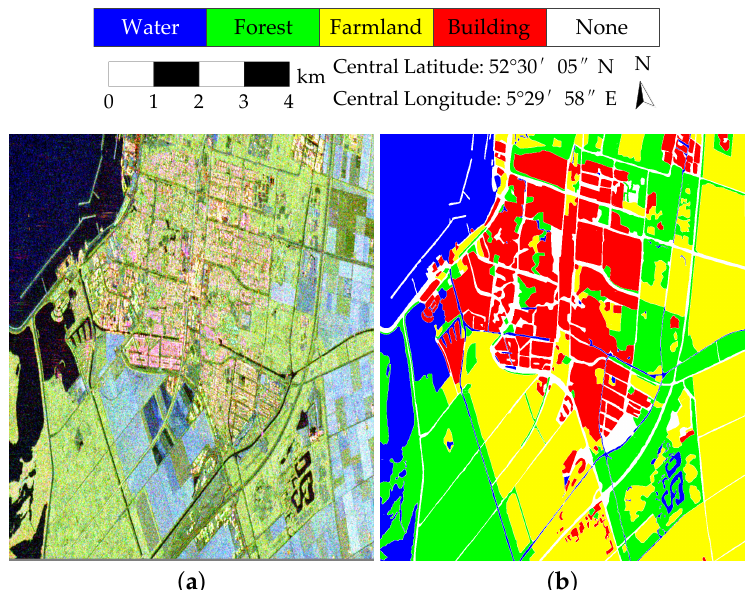
Figure 6. RS-2 Flevoland dataset and the ground truth map. ( a ) Pauli pseudo-color image of RS-2 Flevoland; ( b ) Ground truth map of RS-2 Flevoland.